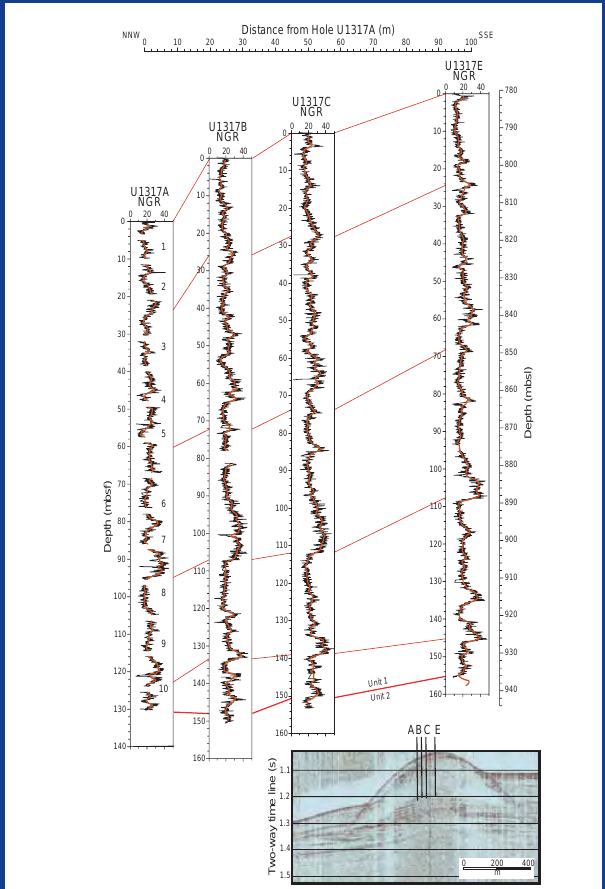
Figure 7. Transect of holes at Site U1317 on the seaward side of Challenger Mound. The natural gamma distributions show the variations in strata that will be used to form a stratigraphic framework for interpreting mound growth. The track data are arranged to re fl ect the variations in water column depth at each hole.